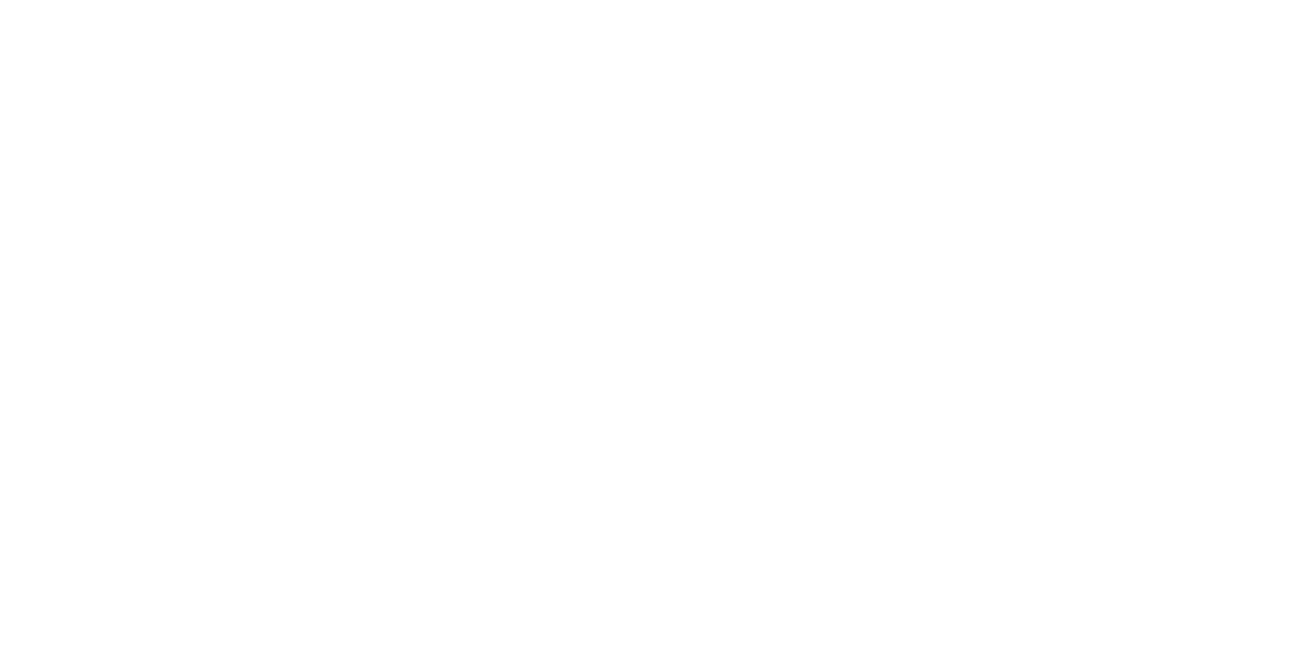
Frontiers in Marine Science | www.frontiersin.org